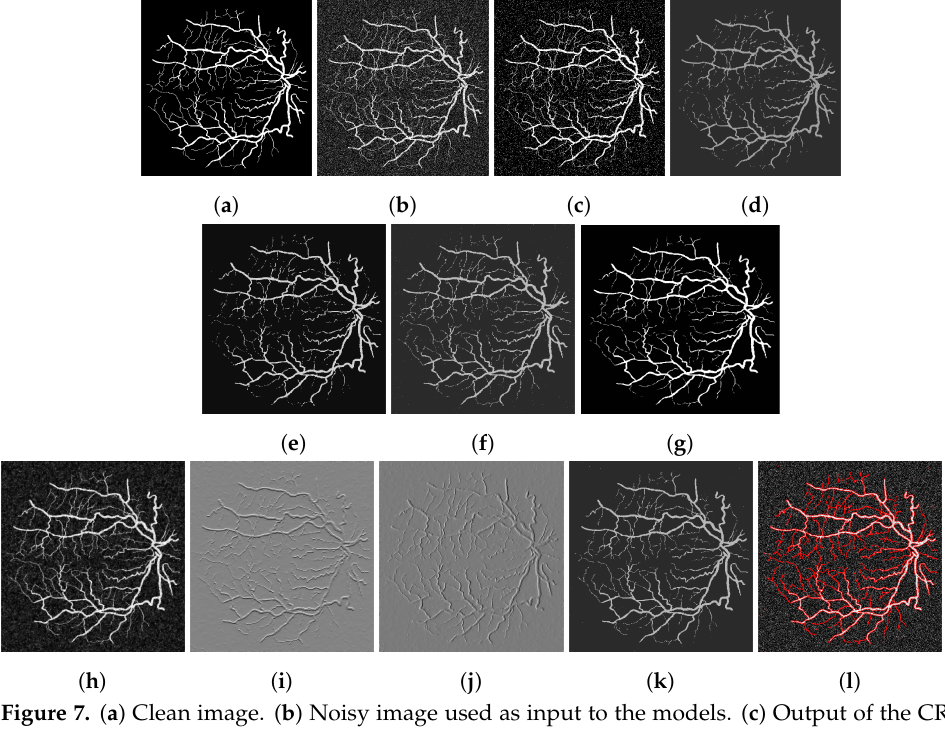
Figure 7. ( a ) Clean image. ( b ) Noisy image used as input to the models. ( c ) Output of the CRCV model. ( d ) CCZ after thresholding. ( e ) CNC after thresholding. ( f ) T-ROF after thresholding. ( g ) DL output. ( h ) Output g of our model. ( i ) Output G x of our model. ( j ) Output G y of our model. ( k ) Ours after thresholding. ( l ) Our contour.